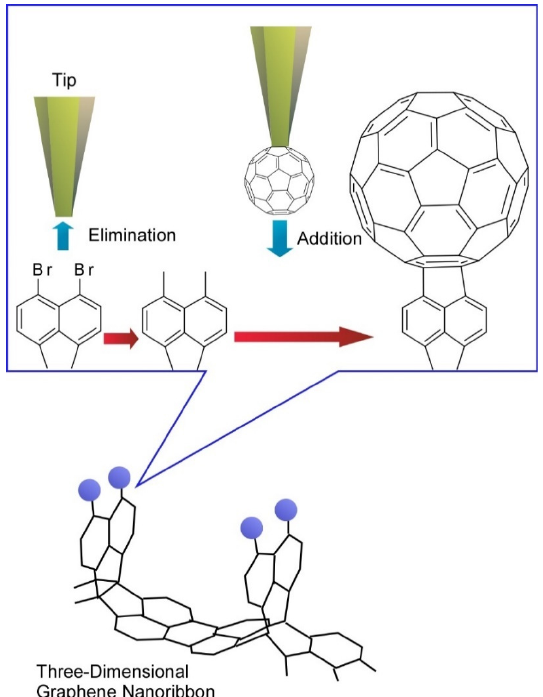
Figure 10. Tip-induced debromination with substitution reaction with fullerene molecule were at three-dimensional graphene nanoribbon. three-dimensional graphene